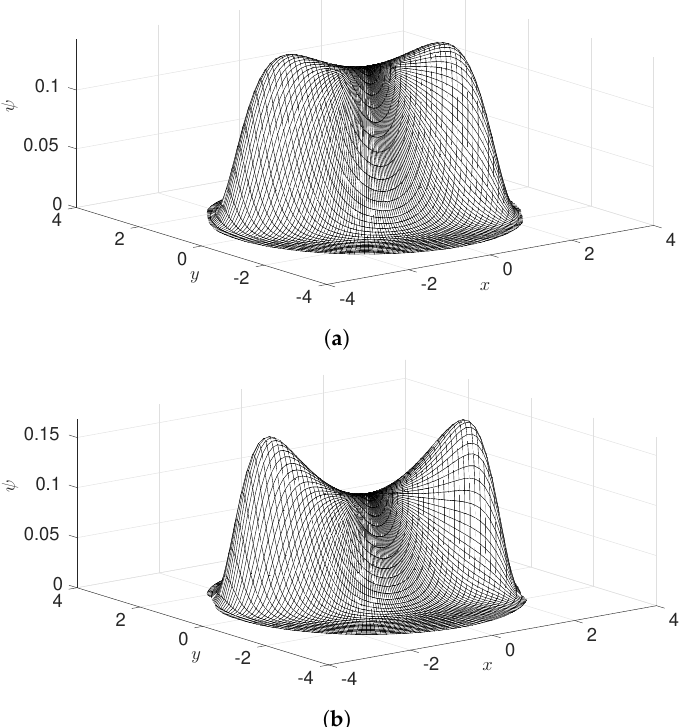
Figure 5. The probability density function ψ for the full nonlinear FENE solution with ˙ γ = 1 for f = 0 and b = 10 with ( a ) f = 0 and ( b ) f =